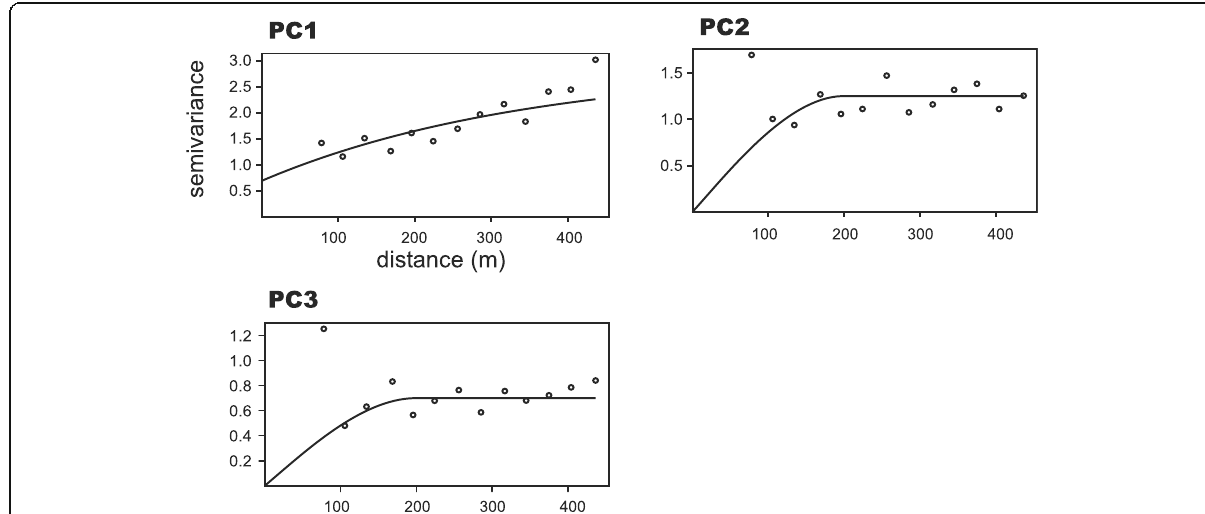
Fig. 8 Semivariograms and fitted variogram models of principal components (PC1 – PC3). The variogram models were fitted by the least-squares method, and the model that produces the fewest residual errors was chosen from among the Gaussian, spherical, and exponential models. The exponential model was used for PC1 and the spherical model for PC2 and PC3